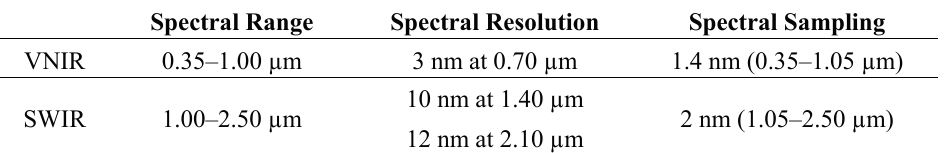
Table 1. ASD FieldSpec Pro specifications.